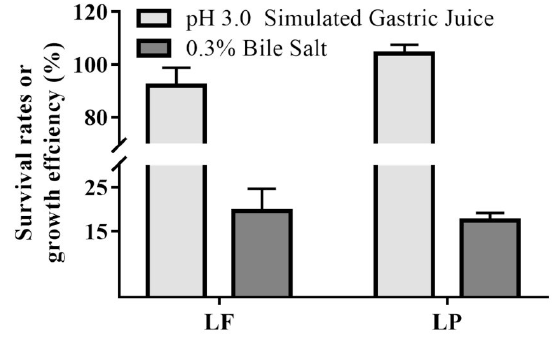
Figure 3. Effects of stimulated gastric juice and bile salt on strains.